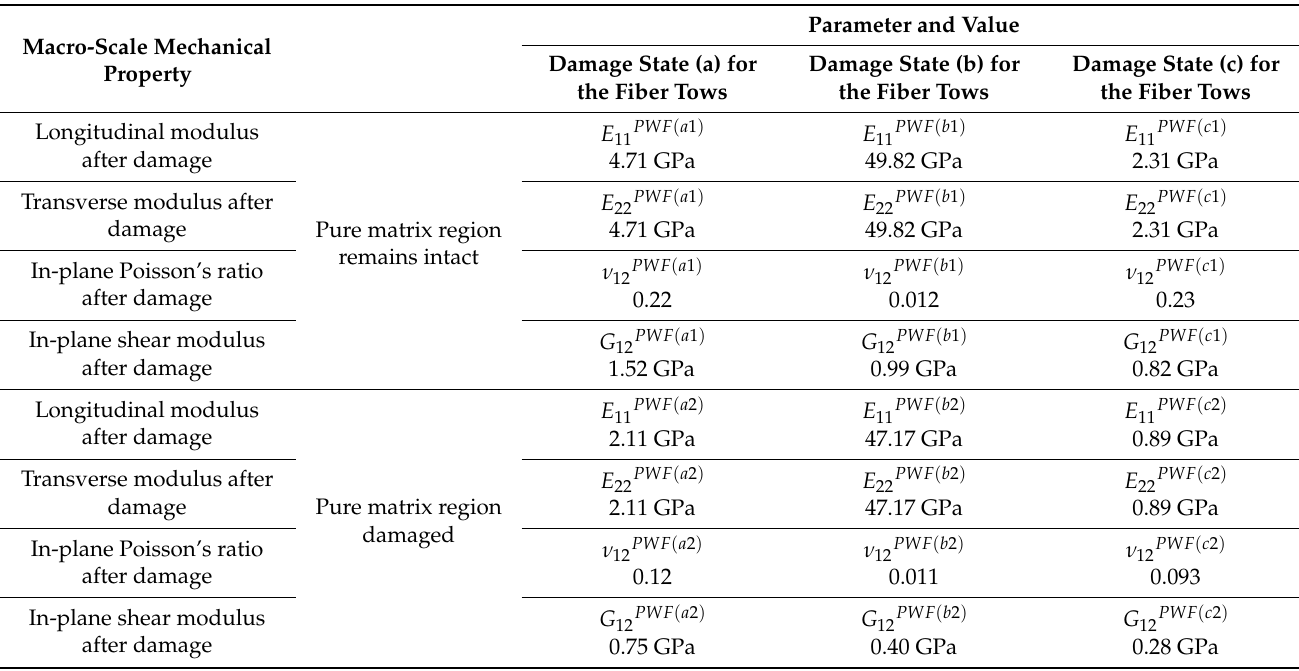
Table 14. Macro-scale mechanical properties of the T300/Epoxy PWF composite after the damage